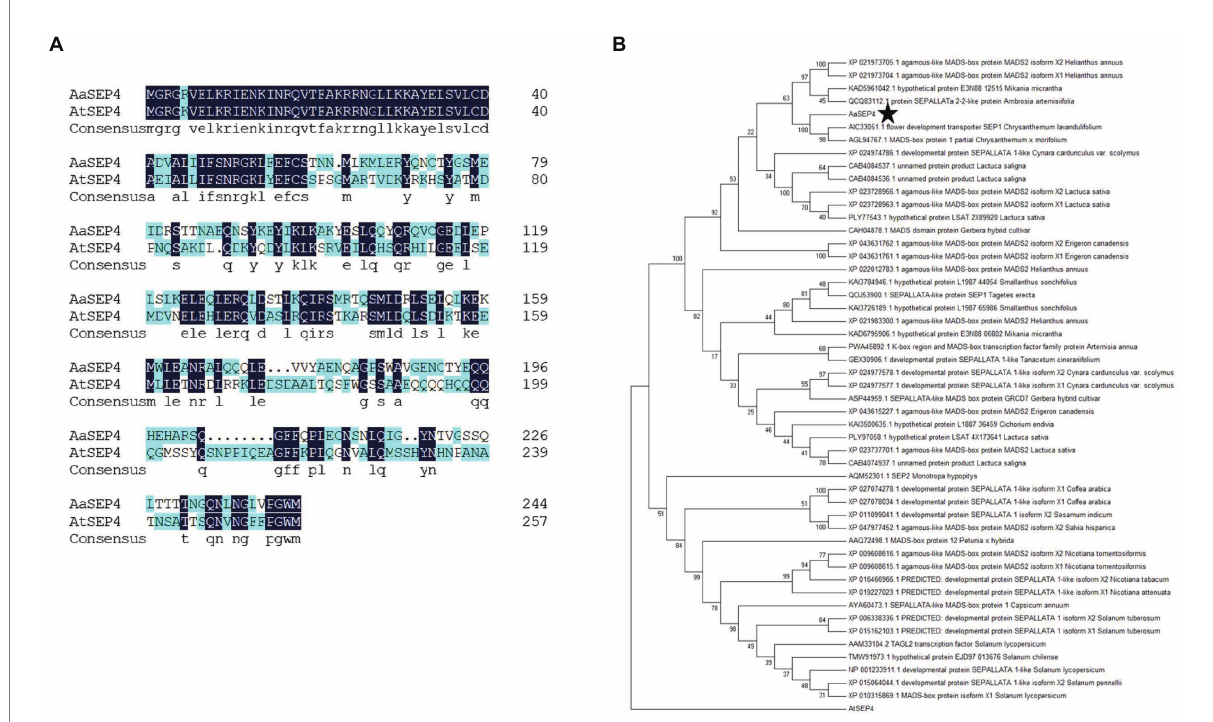
FIGURE 1 Phylogenetic analysis of AaSEP4. (A) The protein sequence alignment of AaSEP4 and AtSEP4. (B) Phylogenetic analysis was performed using MADS family proteins from various other plant species. The tree presented here is a neighbor-joining tree based on amino acid sequence alignment and constructed using the program